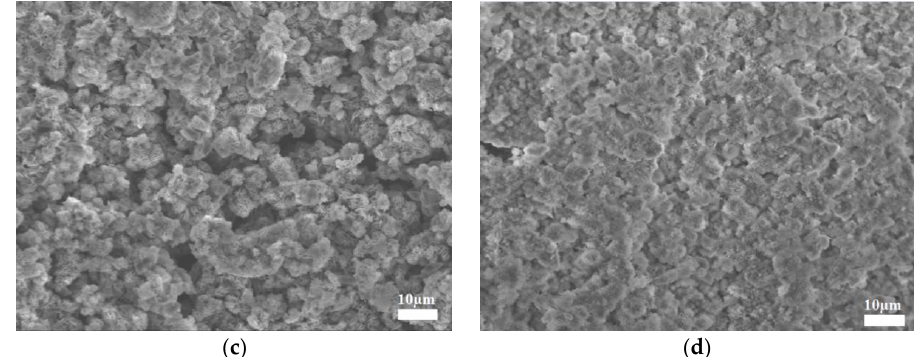
Figure 4. The surface micro-morphology of the four Zn-Al-Mg-TiO 2 coating samples, magnified 1000×, after experiencing different corrosion times: ( a ) corrosion 144 h; ( b ) corrosion 240 h; ( c ) corrosion 480 h; ( d ) corrosion 720 h.